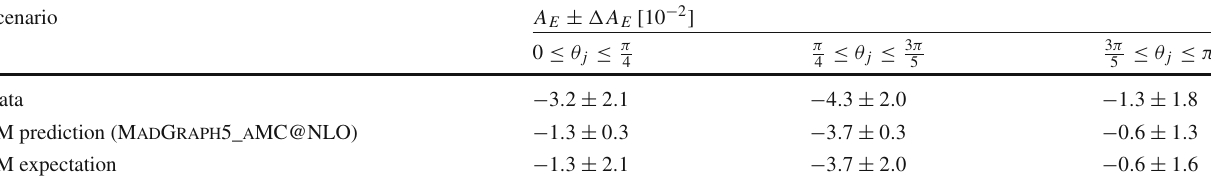
Table 3 The measurement (‘Data’) of the energy asymmetry in three bins of the jet angle θ j is compared with the ‘SM prediction’ obtained from simulations of t ¯ t j events with MadGraph5_aMC@NLO + Pythia8 at NLO in QCD for t ¯ t j + PS, including MC statistical and